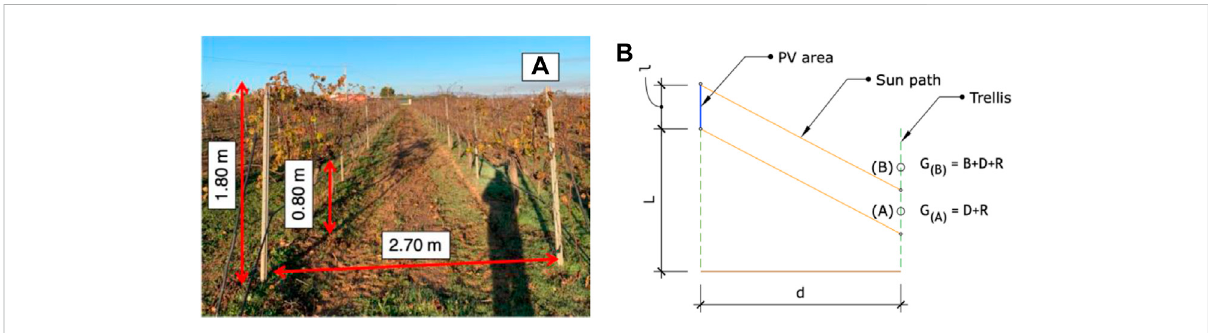
FIGURE 1 (A) Layout trellis dimensions from trellised vineyard located in the experimental farm of the Technical University of Cartagena (Spain). (B) Schematic arrangement of the agrivoltaic solution. Incident irradiance on the trellis is calculated based on the Sun path and irradiation